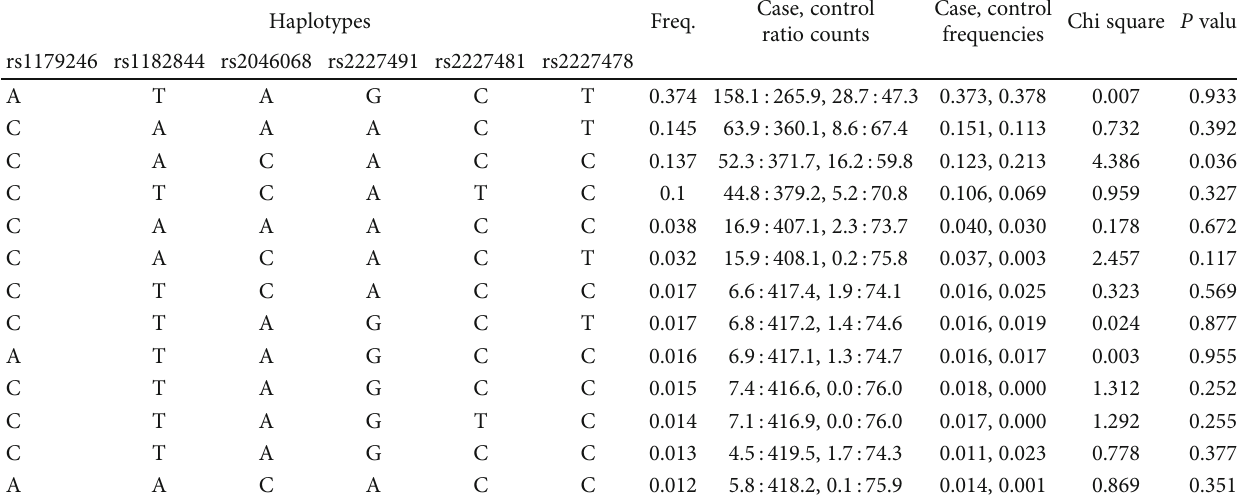
Table 7: Haplotypes of IL-22 gene when group I+II of parasite density was compared to group III+IV. Haplotypes Freq.